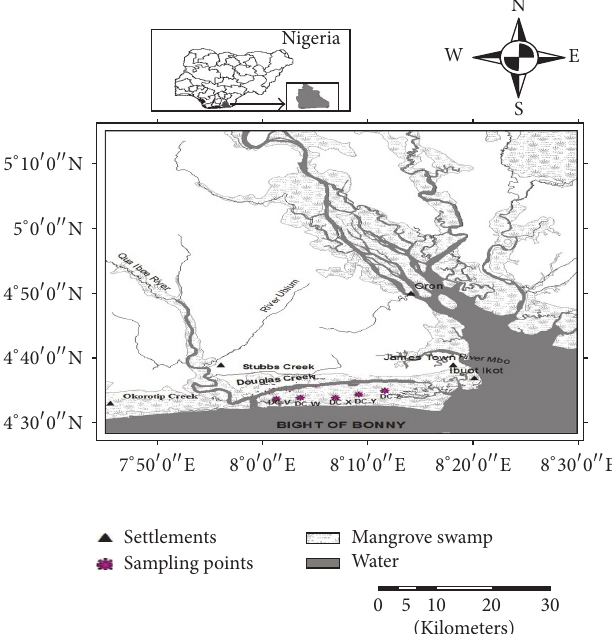
Figure 1: Qua Iboe Estuary mangrove ecosystem showing the sampling location along Douglas Creek. Insert: map of Nigeria showing the location of the study